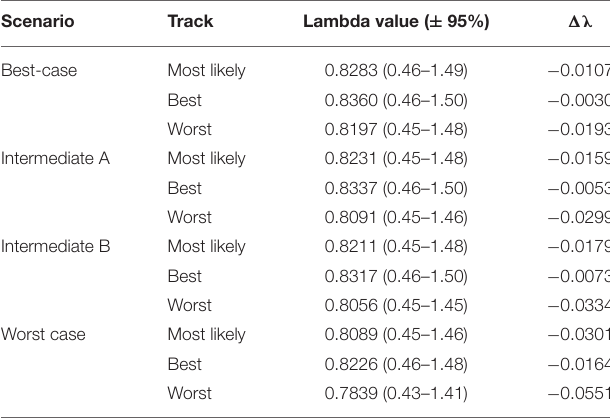
FIGURE 2 | The impacts from future drivers in the western monarch population as predicted by our model. The impact is represented by a magnitude change above or below baseline lambda estimates and grouped by scenario along they x-axis. The colors represent the specific impacts and shapes represent the three expert elicited tracks created for each scenario (see legend). TABLE 3 | Western population scenario specific λ values with 95% confidence intervals after incorporating scenario specific